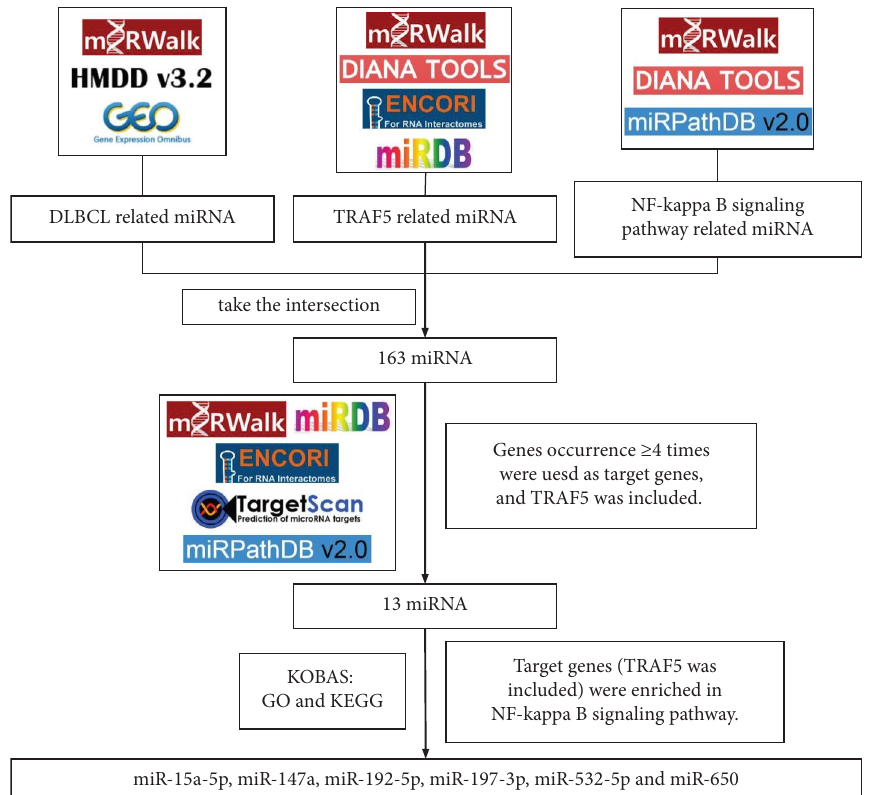
Figure 5: Flow chart of miRNAs screening that target TRAF5 in DLBCL and participate in NF-kappa B signaling